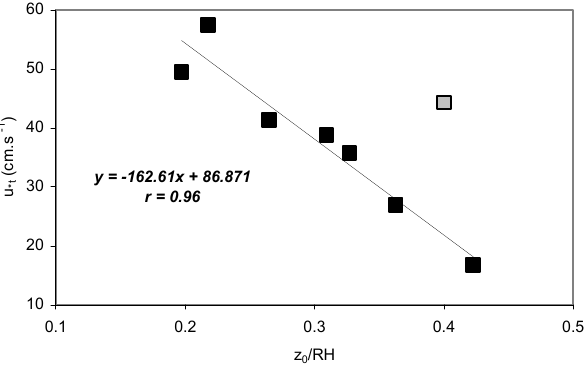
Fig. 3. Calculated threshold wind friction velocities for aeolian ero- sion versus z 0 /RH .